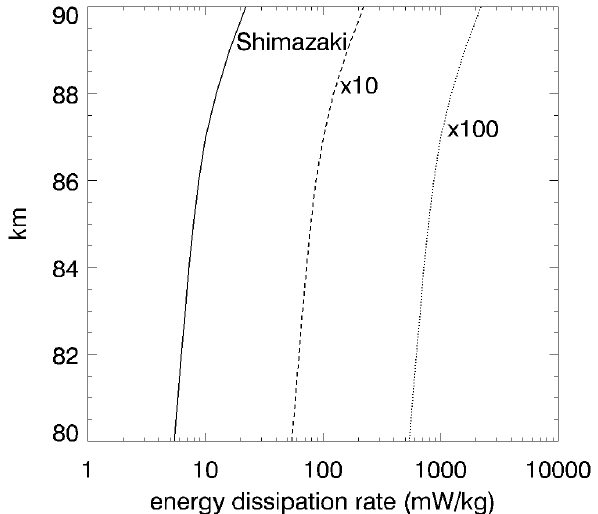
Fig. 2. Modelled (see text) turbulent energy dissipation rates. Solid line: Shimazaki (1971) shape normalized to Danilov and Kalgin (1996); Dashed line: moderate turbulence scenario (solid line × 10); Dotted line: strong turbulence scenario (solid line ×